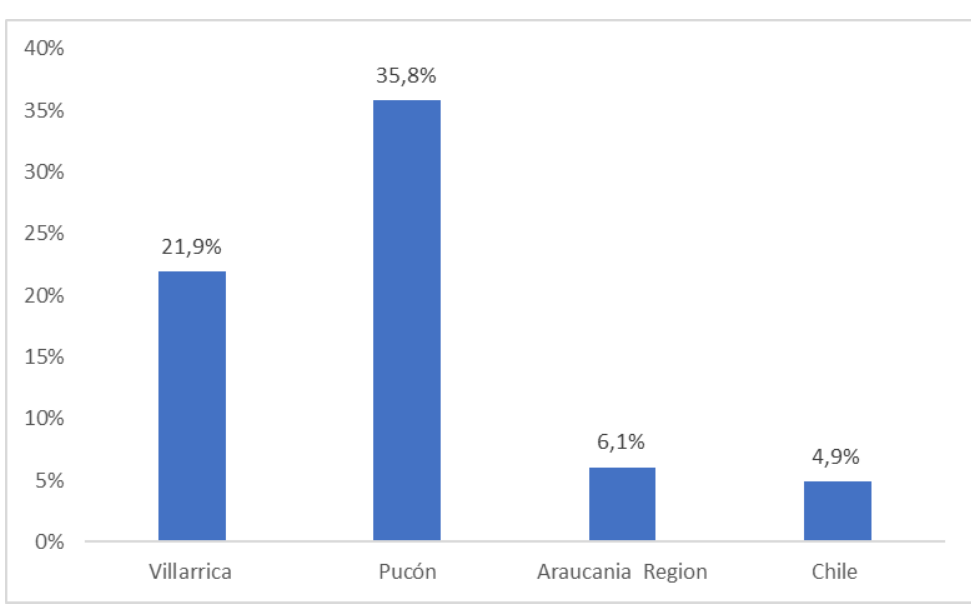
Figure 6. Seasonally occupied homes. Source: compiled by the authors using census microdata from 2017.